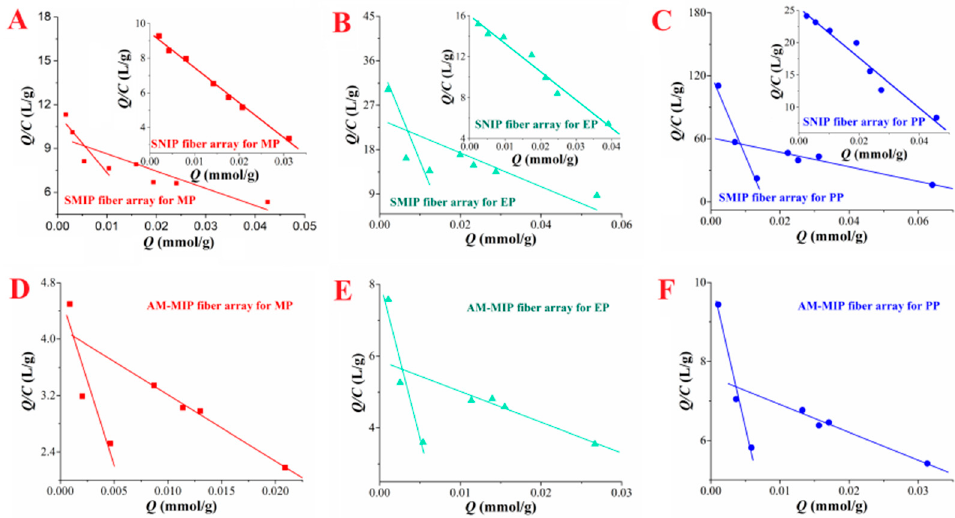
Figure 6. Scatchard fitting curve. ( A – C ). SMIP fiber array and SNIP fiber array for the adsorption of three parabens; ( D – F ). AM-MIP fiber array for the adsorption of three parabens. Table 3. Scatchard fitting parameter analysis.